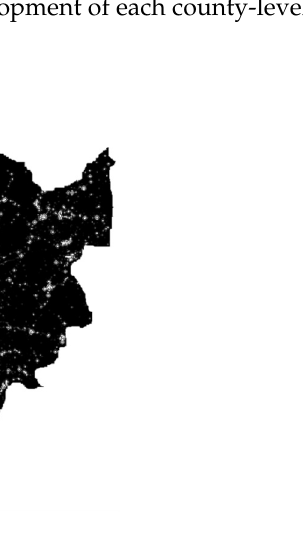
y = 0.0992x R² = 0.7577